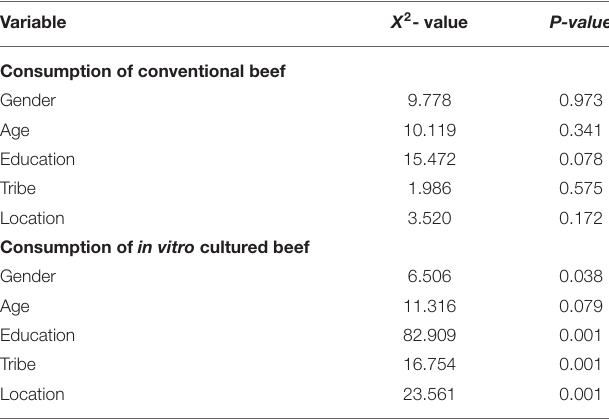
TABLE 3 | Effect of demographic factor on consumption of beef in Eastern Cape Province of South